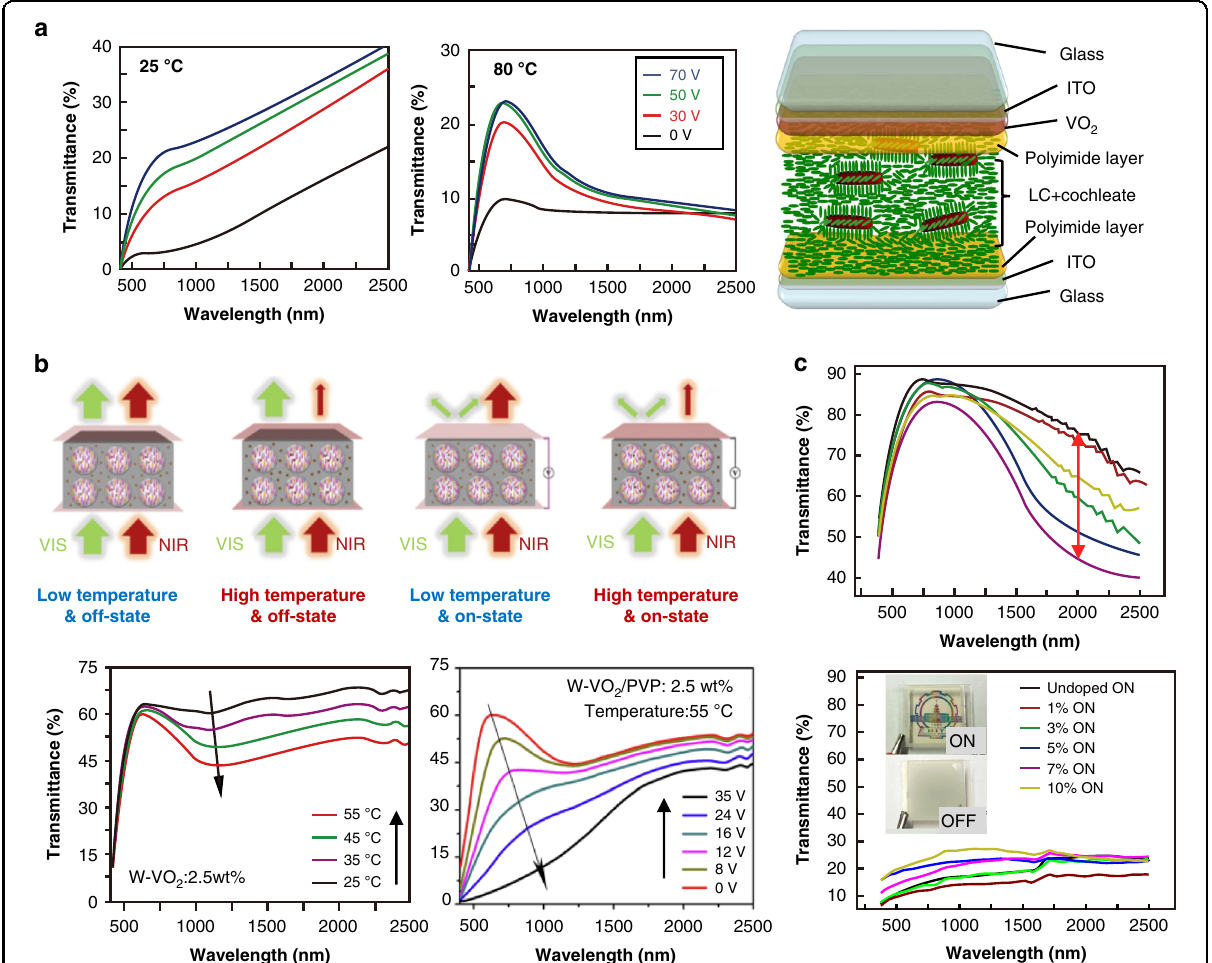
Fig. 16 Switchable optical devices with IR shielding performance. a Schematic illustration of the VO 2 -based LC-cochleate device and transmission spectra of the device plotted as a function of wavelength at different temperatures. Reproduced with permission from ref. 174 . Copyright 2021, Optica Publishing Group. b Four optical modulation modes realized in a hybrid microscale/nanoscale composite fi lm with W-VO 2 and variations in the vis/NIR transmittance spectra. Reproduced with permission from ref. 175 . Copyright 2017, American Chemical Society. c Schematic of ATO NPs -doped in a PSLC smart fi lm with on/off states and light protection control. Reproduced with permission from ref. 177 . Copyright 2021, Royal Society of